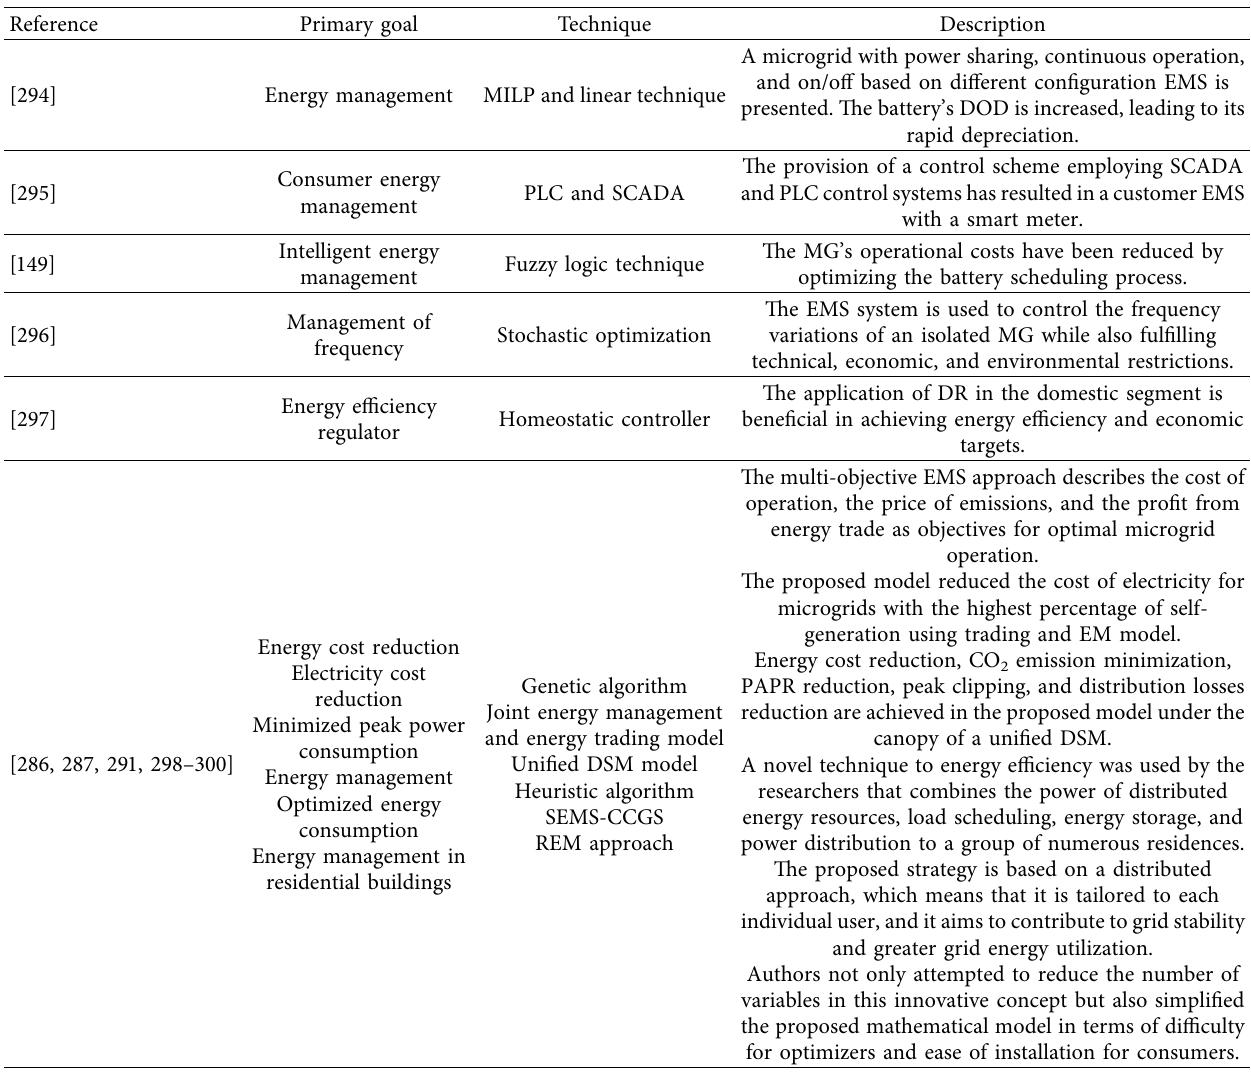
Table 10: EMS techniques with